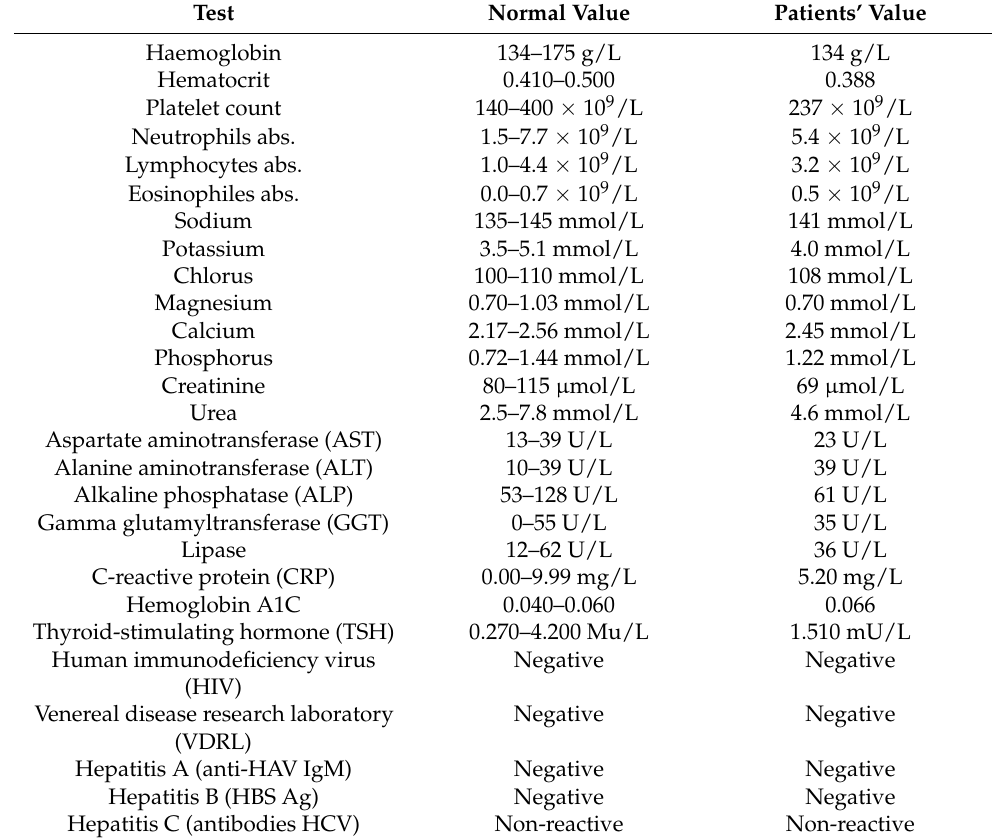
Table 1. Laboratory testing